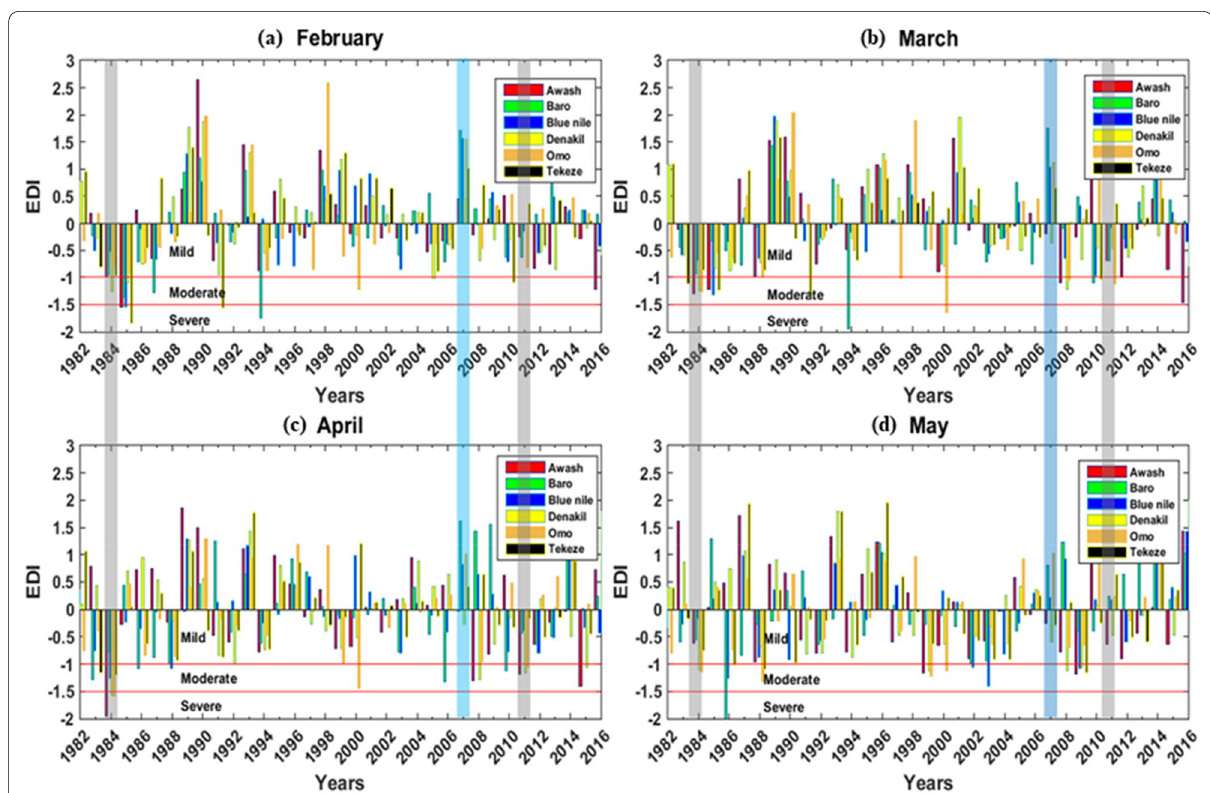
Fig. 3 Time series plots of basin-wide EDI values during smaller rainfall months ( a – d ) between 1982 and